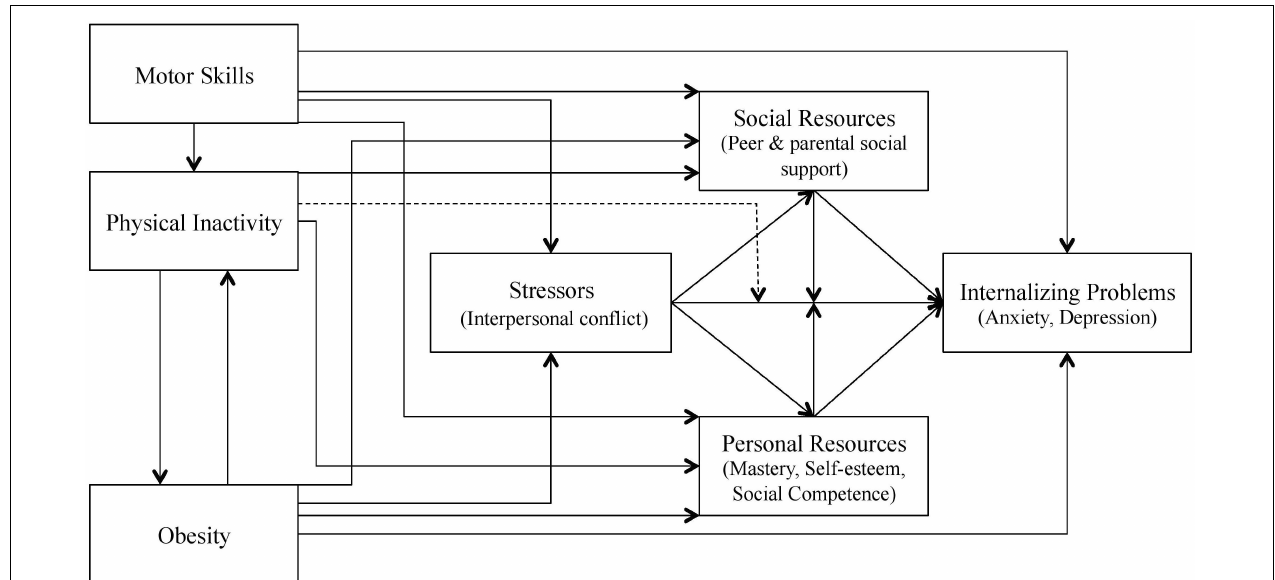
FIGURE 1 | The adapted Environmental Stress Hypothesis by Mancini et al.